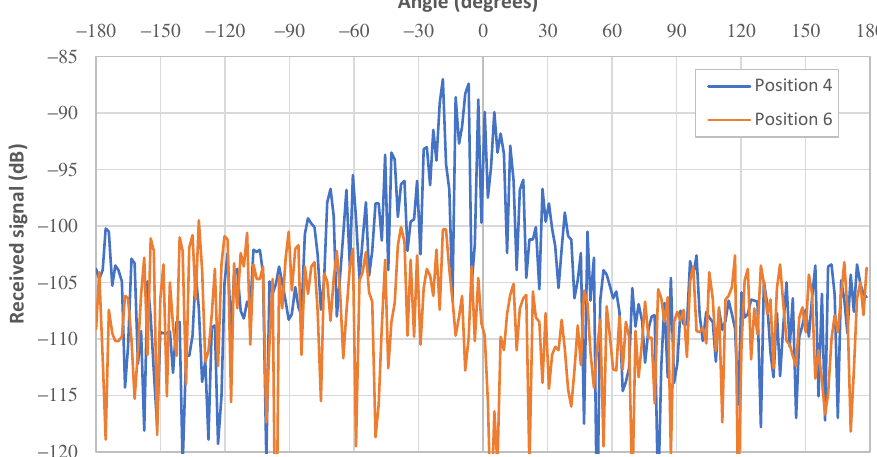
Figure 10. Received signal after deconvolution for two receiver positions.